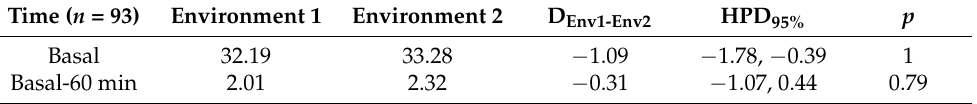
Table 2. Effect of Environments on basal temperature and temperature range between basal and 60